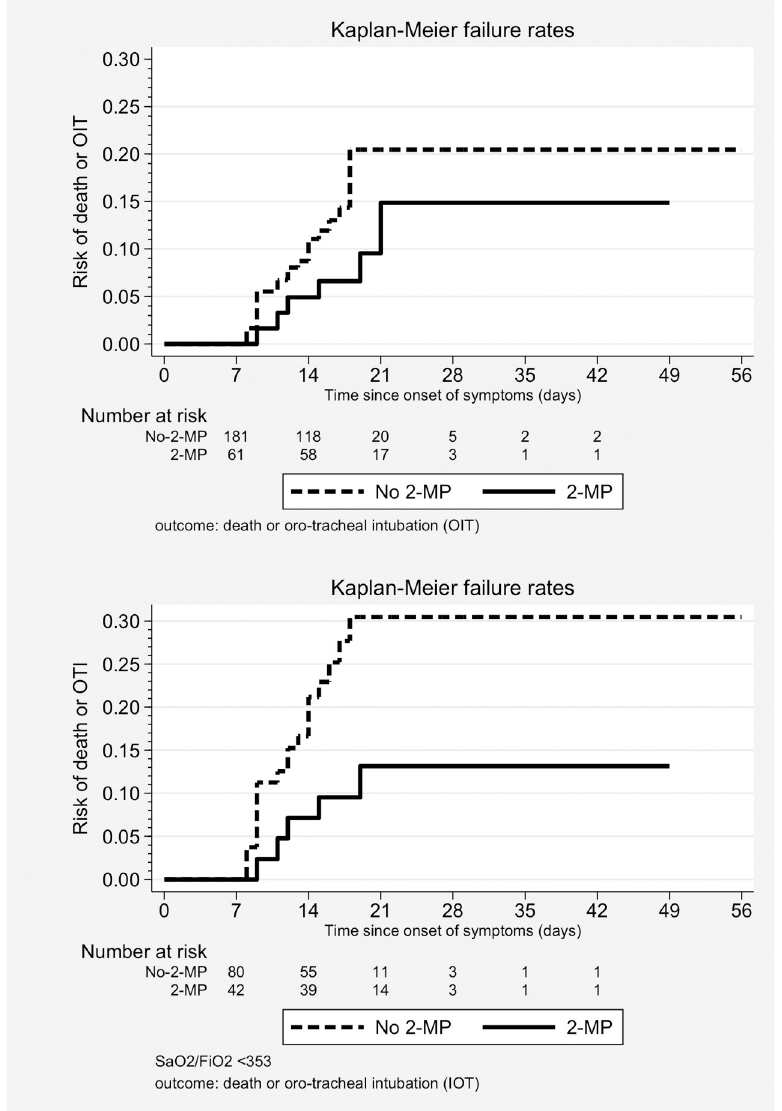
Fig 2. Kaplan-Meier failure curves, second week methyl-prednisolone pulses (2-MP) vs. no 2-MP. Outcome: death or intubation. (a) Whole cohort (n = 242). Log-rank test, p = 0.125. (b) Patients with low SpO2/FiO2 (n = 122). Log- rank test, p =